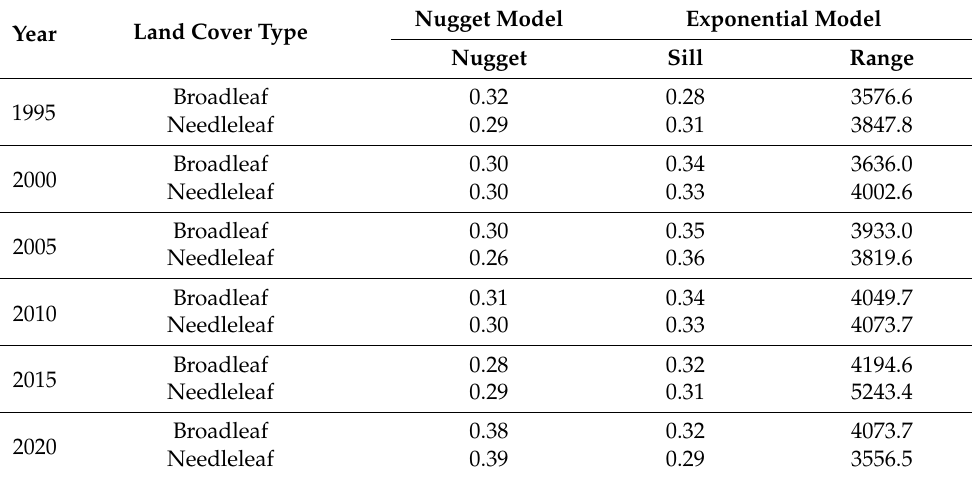
Table 1. Fitting Parameters of Variograms for Broadleaf Forest and Needleleaf